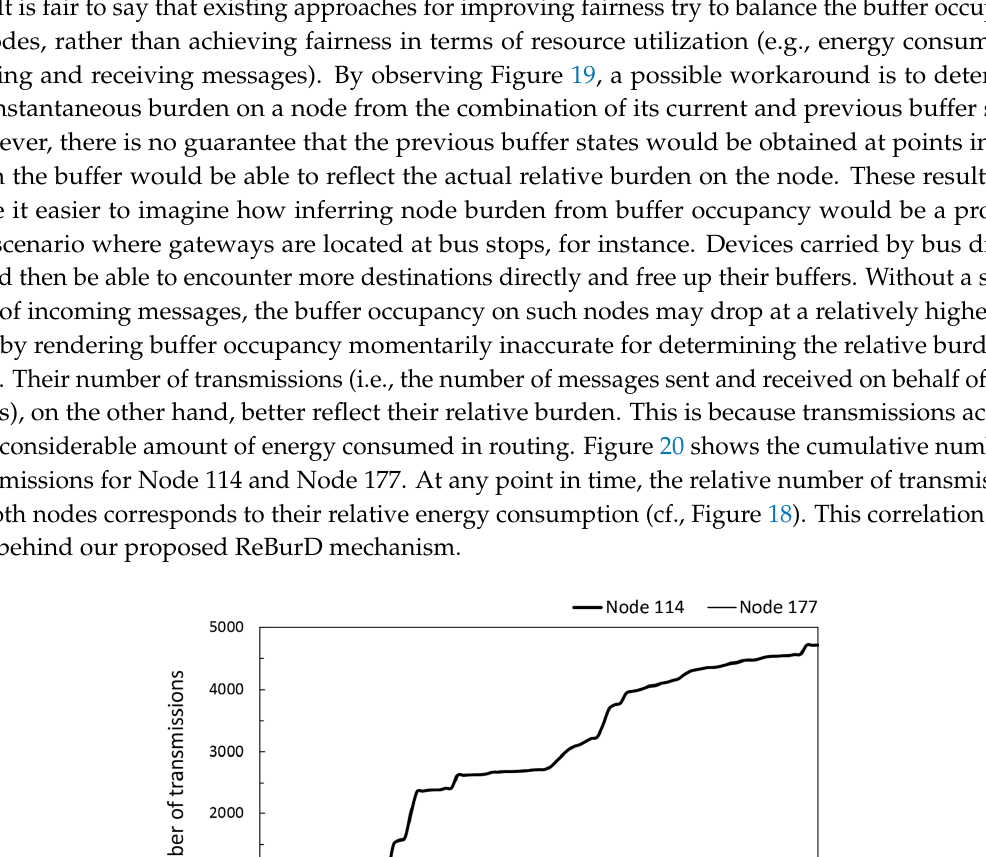
Figure 19. Buffer occupancy against time for Node 114 and 177.